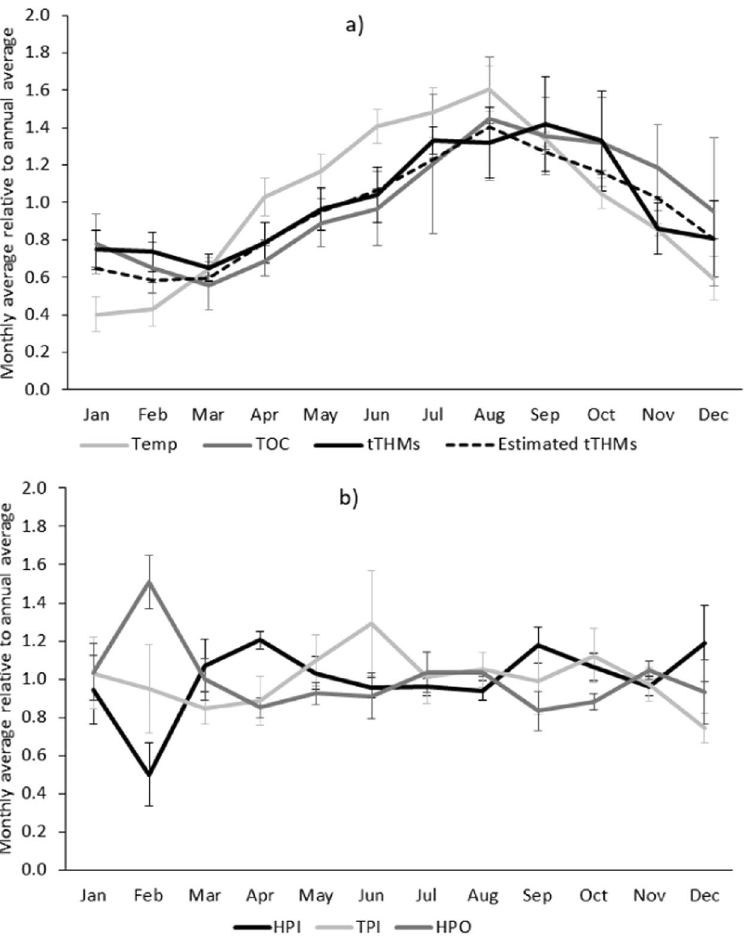
Figure 1. Seasonality in ( a ) the average potable water quality, and ( b ) the average dissolved organic carbon (DOC) composition, expressed as % hydrophobic organic fraction (HPO), transphilic organic fraction (TPI) and hydrophilic organic fraction (HPO), in potable water of five Scottish water treatment plants. Error bars indicate the standard error (n = 5) for the monthly average, relative to the annual average, calculated for the case study sites. Annual average values were 9.66 °C for temperature, 1.08 mg/L for TOC, 43.93 mg/L for THMs, 40.1% for HPI, 18.6% for TPI and 41.3% for HPO.